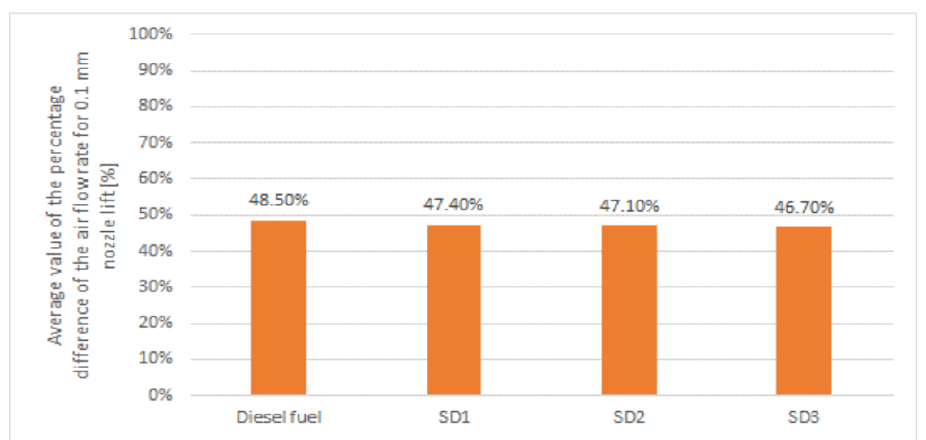
Figure 15. The mean value of the airflow rate difference (expressed as a percentage) for a 0.1 mm nozzle lift in the CEC test